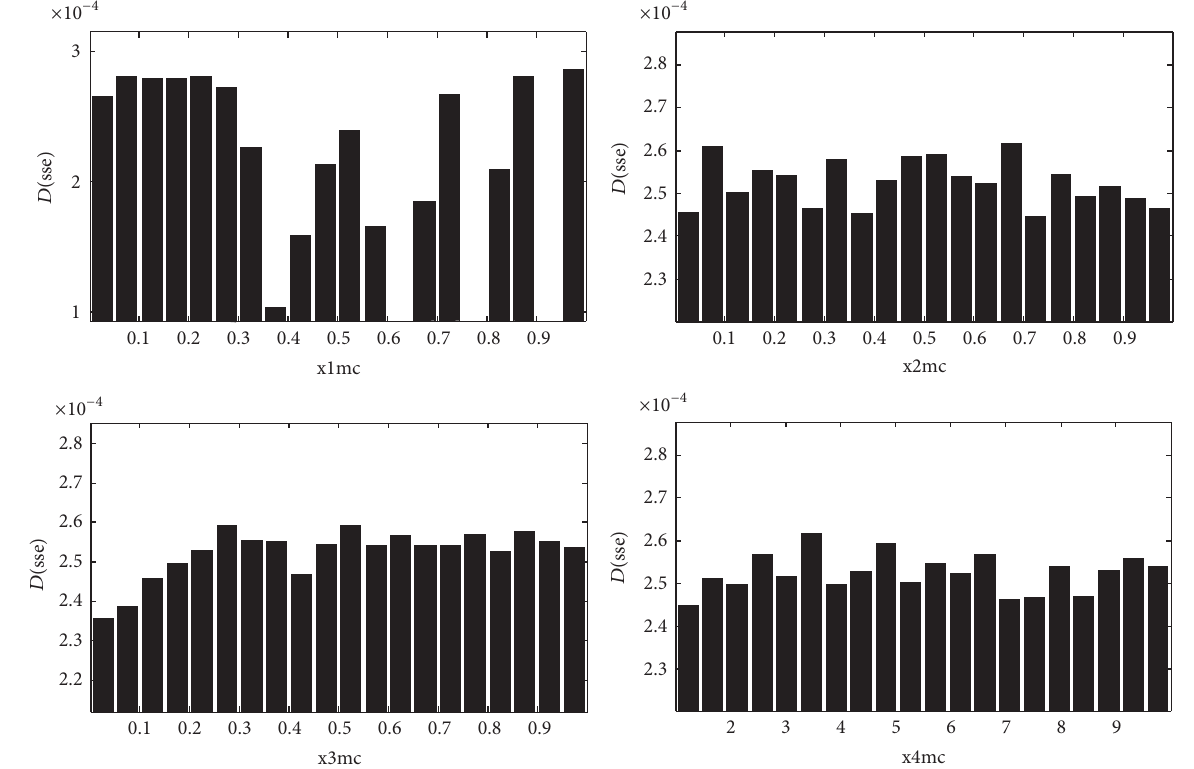
Figure 2: Posteriori parameter